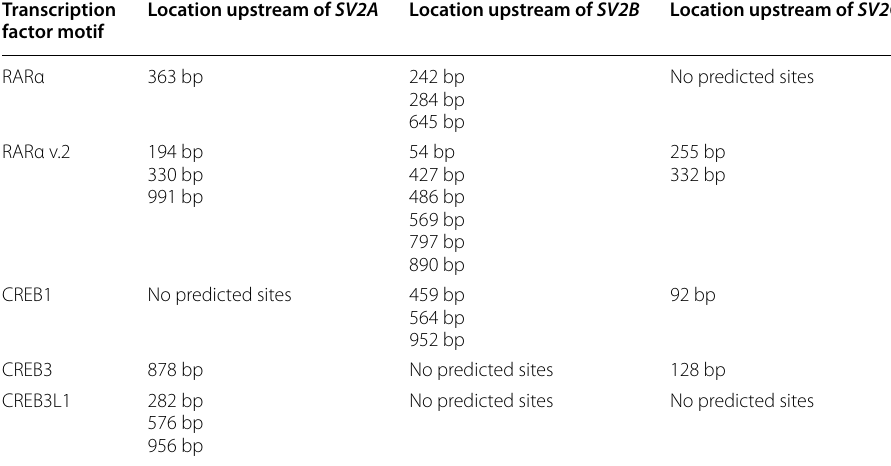
Table 2 Localization of gene activation sites upstream of transcription start sites of human genes SV2A , SV2B and SV2C